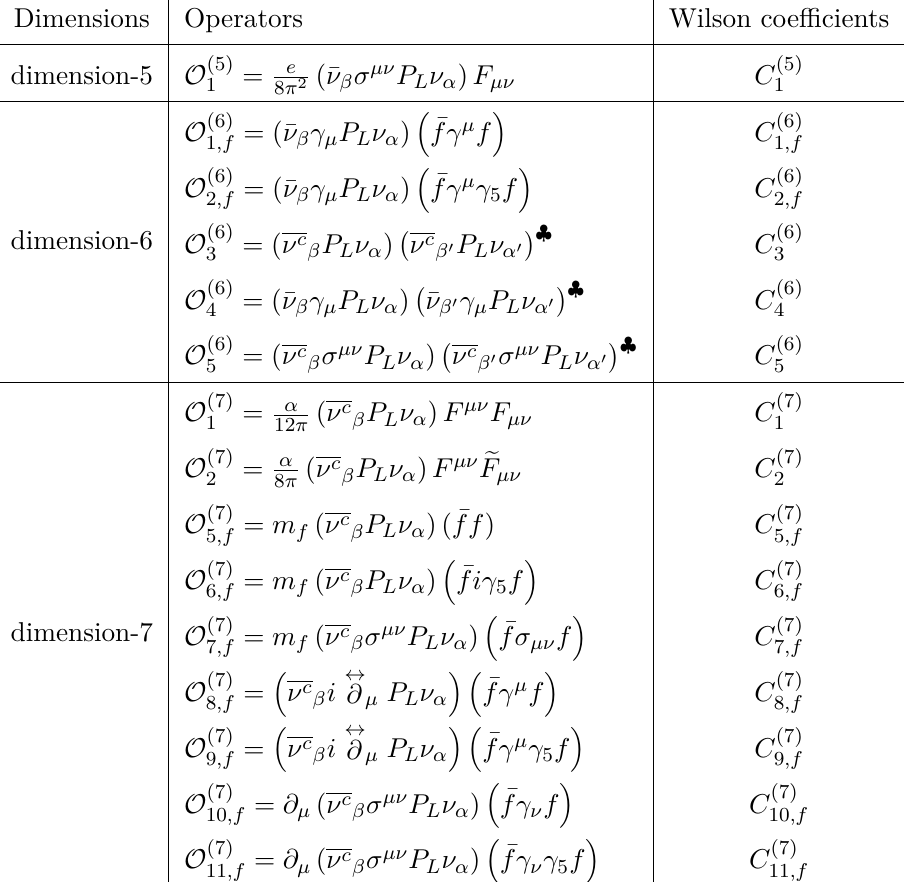
Table 1 . Effective operators relevant for N eff up to dimension-7 with α, β, α 0 , β 0 = e, µ, τ , the neutrino flavor indices, and f = e . Operators with ♣ ’s are the extra operators we consider in this work and the symbol “ c ” along with related operators means charge conjugation. The last column shows our convention for the Wilson